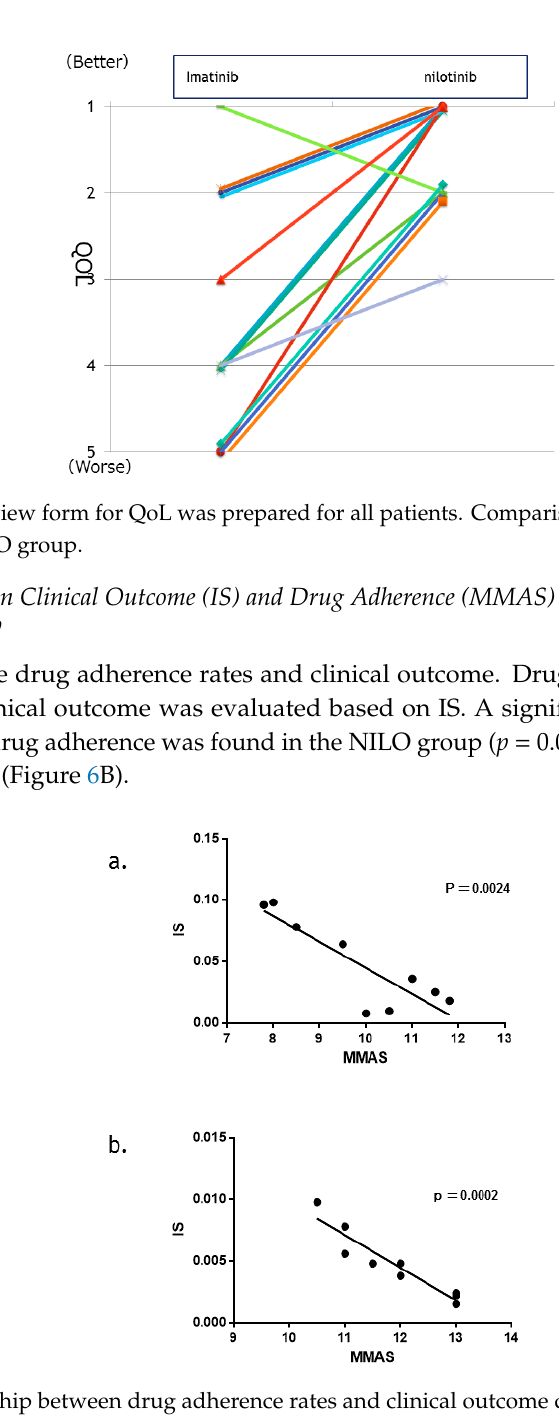
Figure 6. Relationship between drug adherence rates and clinical outcome determined with IS. Drug